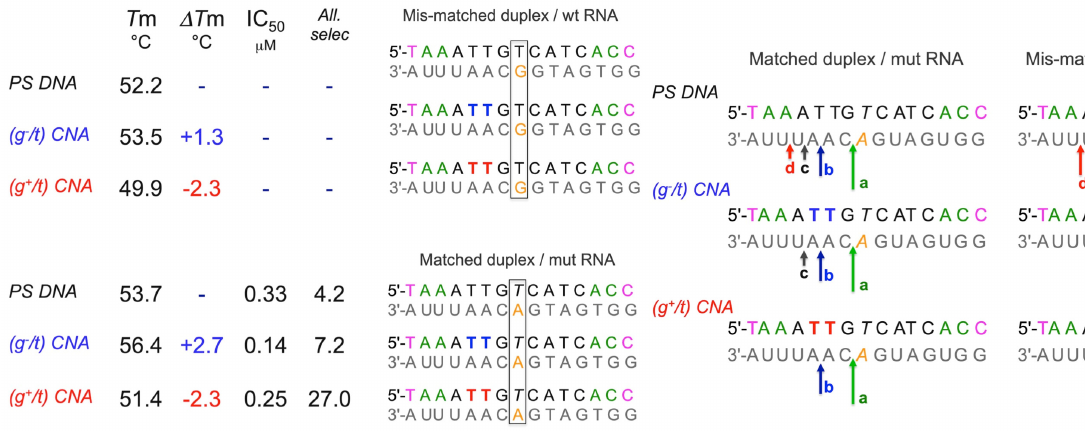
Figure 12. Left: Sequence, chemical modification pattern, thermal melting temperature (Tm) vs wild type RNA with a mismatch (wt RNA) or mutant RNA fully matched (mut RNA), activity against mutated Huntington protein (IC 50 ) and fold selectivity vs wild type Huntington protein (All. Selec) in human fibroblasts. Right: Cleavage pattern by recombinant human RNase H of heteroduplex in a biochemical assay. All ASOs are phosphorothioate wherever possible. Magenta letters denoted 2’- O -methoxyethyl RNA (MOE), green denoted 2’- O -ethyl BNA, blue denoted α , β -D-CNA (g − ,t), and red α , β -D-CNA (g + ,t). Black denoted 2’-deoxynucleotides and grey ribonucleotides.